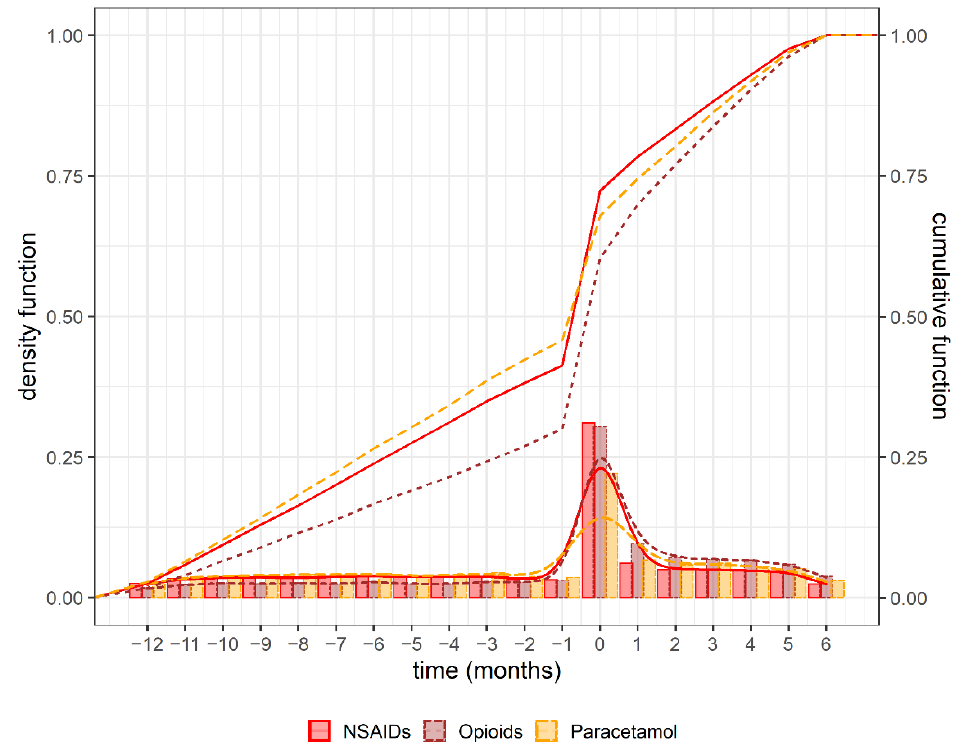
Figure 2. Time pattern of prescriptions: This figure shows the time pattern of pain medication prescriptions in 6449 patients during baseline and follow up period, in months. Primary y-axis: histogram in scale density (density function, lower curves) and its smoothed curve for each pain medication class. It describes the proportion of prescriptions occurring in that time period. Secondary y-axis: cumulative proportion (cumulative function, upper curves) of all pain medication prescriptions over time. It describes the total prescription rate up to the time period. NSAIDs: non-steroidal anti-inflammatory drugs.